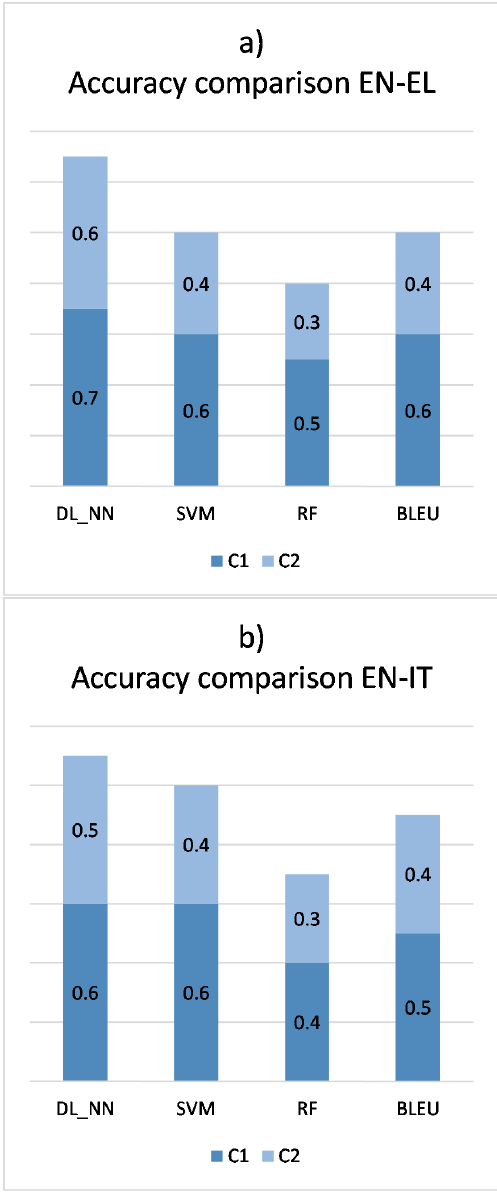
Figure 3. Accuracy performance (Kendall τ ) compared with related